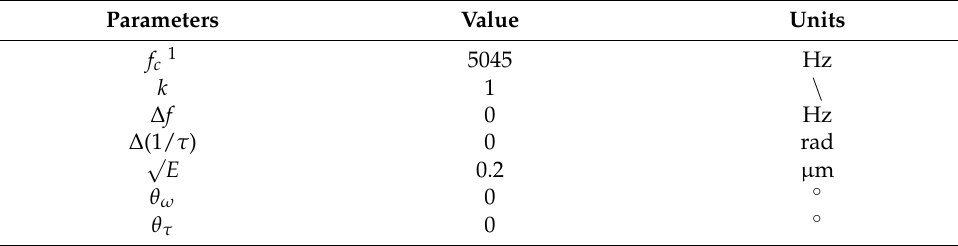
Figure 3. Simulation results for ( a ) angular rate output in RIG mode and ( b ) scale factor fitting curve. Table 1. Simulation parameters related to rig operation mode.